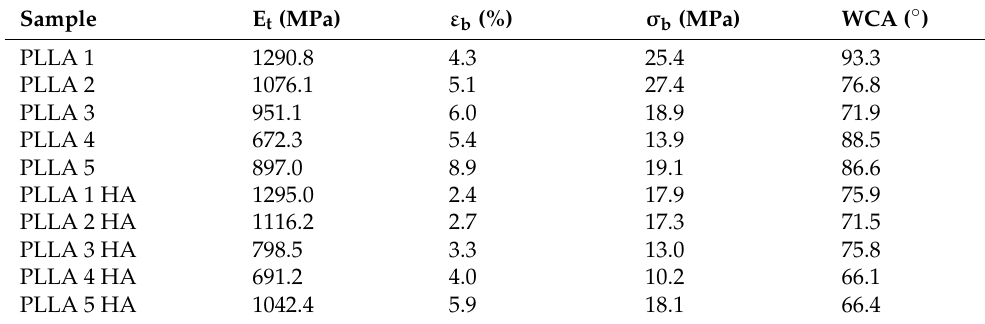
Table 4. Properties of composite polyester materials: tensile modulus (E t ), elongation at break ( ε b